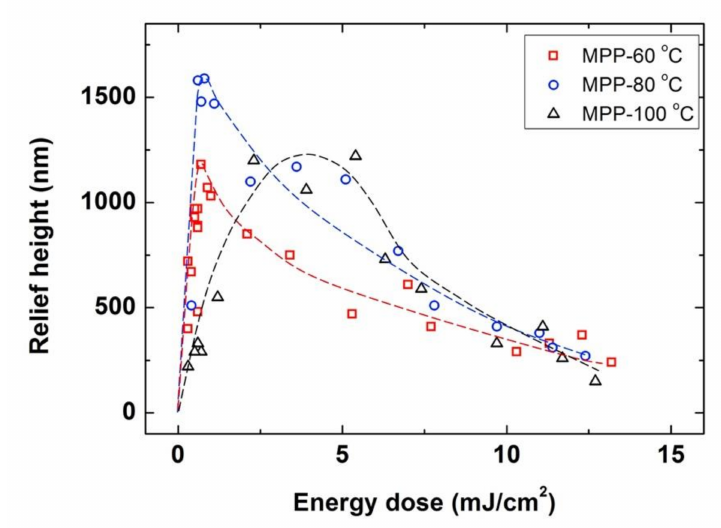
Figure 3. Modified photoembossing protocol (MPP) comprising an exposure step using IL (single pulse exposure and 9 µ m period grating) carried out directly at the development temperature. Relief height as a function of energy dose for different development temperatures of 60 °C ( ), 80 °C ( ) and 100 °C ( ). Lines are drawn to guide the eye.